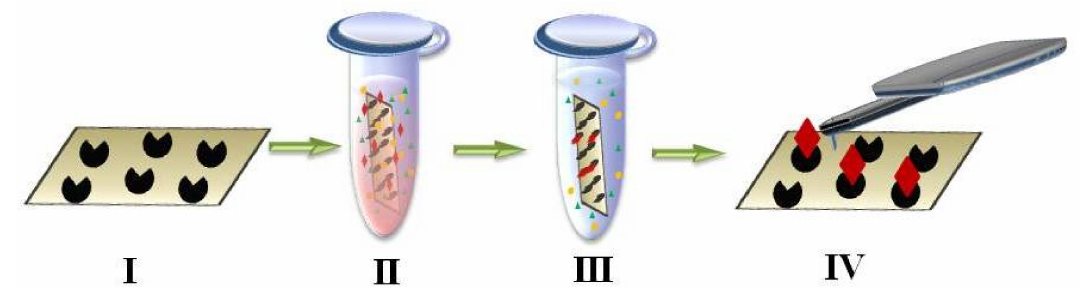
Figure 3. Experimental design of AFM-based fishing includes the following steps: ( I ) functionalization of the chip by immobilizing the bait molecules for further biospecific registration of protein complexes; ( II ) biospecific fishing of protein from solution during chip incubation in analyzed fluid; ( III ) chip rinsing to remove the components adsorbed nonspecifically onto the surface; ( IV ) AFM imaging in a counting mode to detect protein